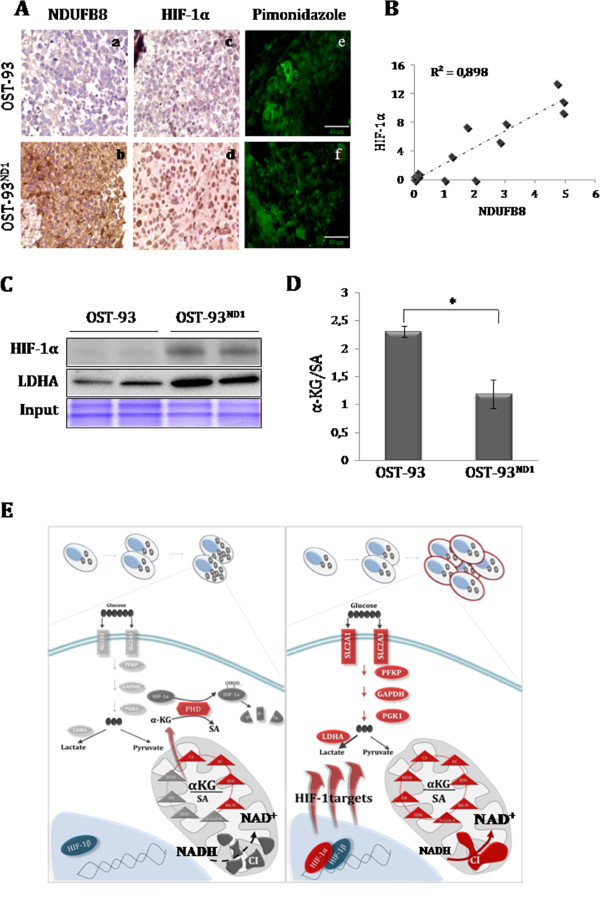
Complex I (CI) rescue correlates with decrease in α-ketoglutarate (α-KG)/ succinate (SA) ratio and recovery of hypoxia inducible factor-1α (HIF-1α) stabilization. (A) Representative immunohistochemical (IHC) analysis of CI (NDUFB8) and HIF-1α in OST-93 and OST-93ND1 xenografts. Positive NDUFB8 (b) and HIF-1α staining (d) is observed in OST-93ND1 but not in OST-93 xenografts (a, c); magnification 100×. Pimonidazole staining of representative OST-93 and OST-93ND1 xenografts (e, f); magnification 63×. (B) Correlation between NDUFB8 and HIF-1α IHC staining scores. X-axis represents NDUFB8 staining scores obtained considering the percentage of positive cells and staining intensity. Y-axis represents the percentage of HIF-1α-positive nuclei. (C) Western blot analysis of HIF-1α and lactate dehydrogenase A (LDHA) protein levels in OST-93 and OST-93ND1 tumors. Coomassie staining was used as loading control (input). (D) The ratio of α-KG and SA levels was calculated by measurements for each metabolite in OST-93- and OST-93ND1-derived cell lines. Data are mean ± SD (n = 3, *P <0.05). (E) Scheme of the metabolic changes in the absence/recovery of functional CI in cancer cells. Non-functional CI leading to an increase of the α-KG/SA ratio (left panel), which may foster activity of prolyl-hydroxylases (PHDs) with subsequent HIF-1α degradation even at low oxygen. Inactivation of HIF-1α leads to the downregulation of glycolysis needed to compensate for the defective mitochondrial respiration. This scenario may not allow the metabolic adaptation of tumor cells, possibly inducing a short-circuited mitochondrial compensatory proliferation. Due to a recuperated NADH consumption, CI rescue restores the α-KG/SA balance (right panel), hence not preventing HIF-1α stabilization. HIF-1α may therefore translocate into the nucleus with HIF-1β and activate transcription of target genes (red ovals and rectangles), among which those contributing to increase the glycolytic flux, hence conferring a Warburg phenotype and allowing tumor adaptation and growth. Red elements indicate activation or overexpression.